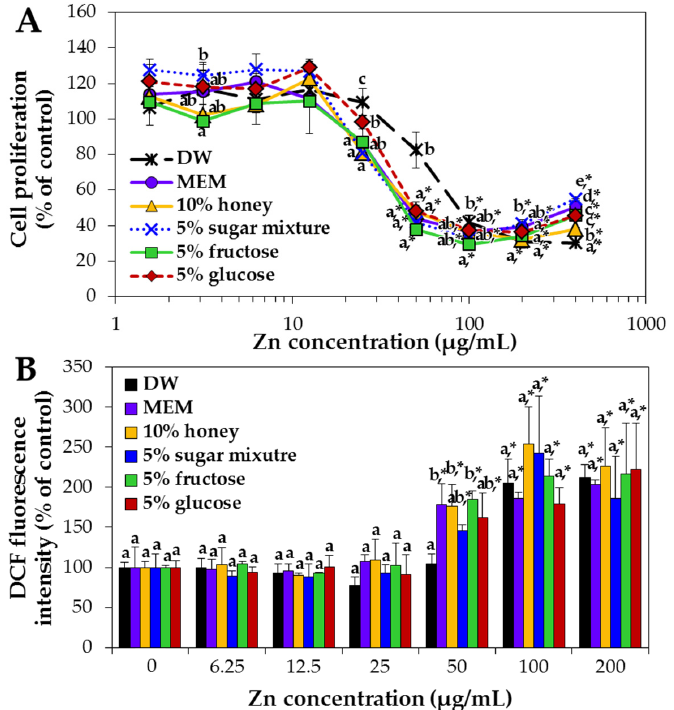
Figure 8. Effects of ZnO NPs suspended in DW, MEM, or different saccharide solutions on ( A ) Caco-2 cell proliferation and ( B ) intracellular ROS generation after 24 h. Different lower-case letters (a–e) indicate significant differences among DW, MEM and different saccharide solutions ( p < 0.05). * denotes significant difference from NPs in DW as a control ( p < 0.05).